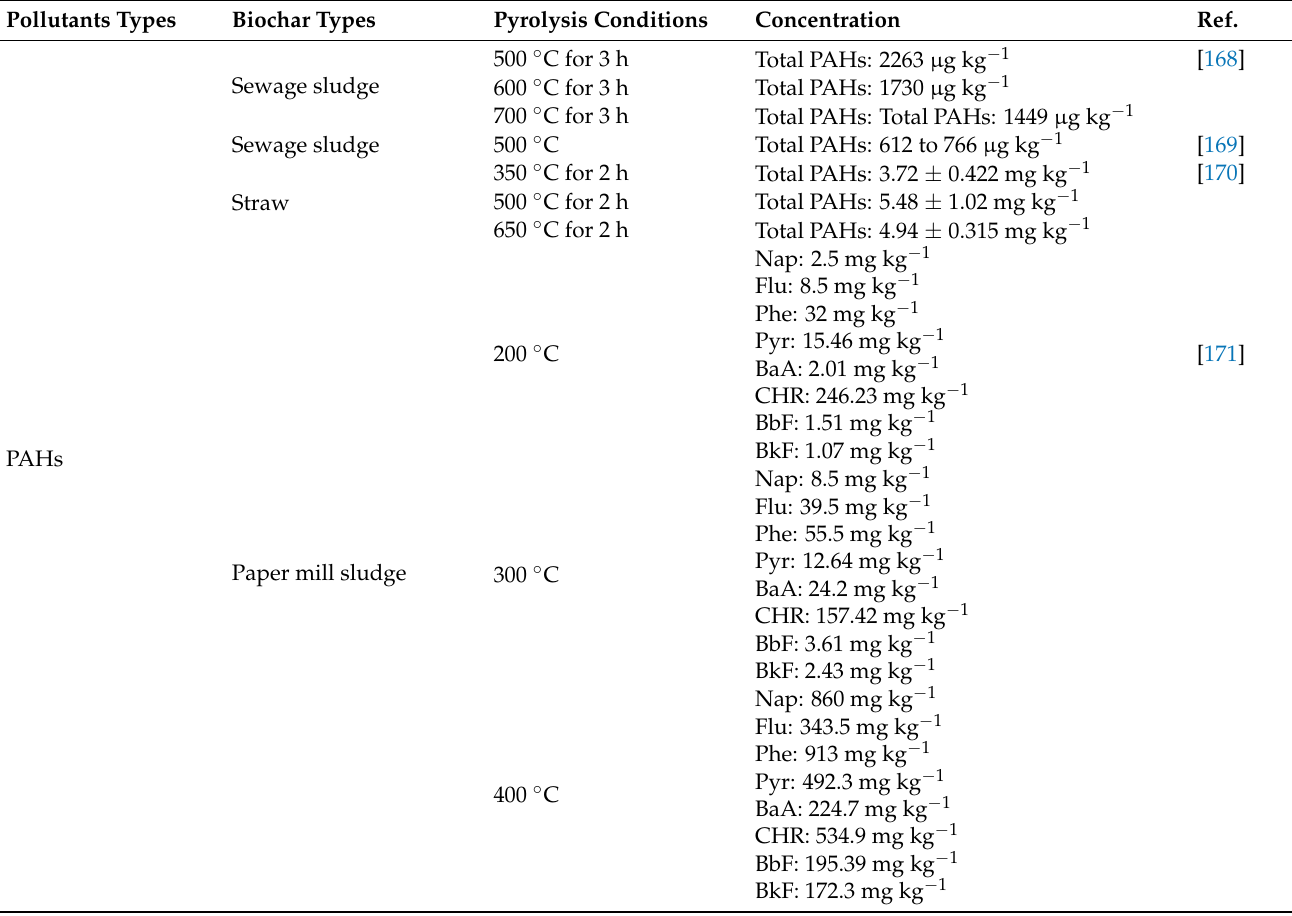
Figure 4. A general view of the contaminants present in biochar regarding to their effect towards living organisms. Table 2. Main pollutants of biochar obtained under different biomass and preparation